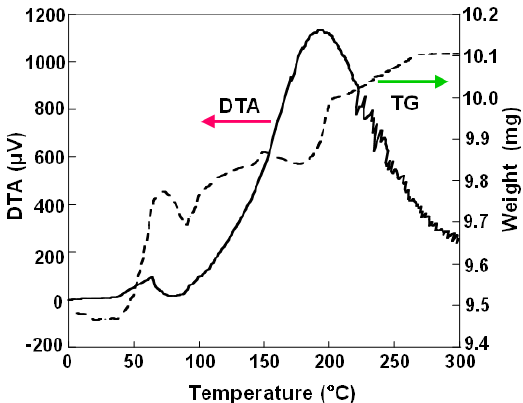
Figure 3. Differential thermogravimetric analysis (DTA) and thermogravimetry (TG) curve of BN nanocapsules and nanotubes produced using LaB 6